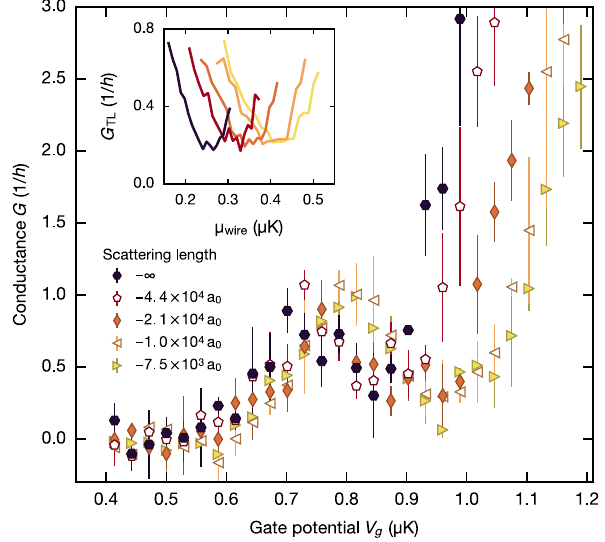
FIG. 5. Robustness of the gap with increasing interactions. Conductance G through a six-barrier lattice of height V 0 . 46 ð 2 Þ μ K as a function of gate potential V scattering lengths ranging from moderately attractive (yellow) to resonant interactions (dark purple). For a one-dimensional density of two particles per site, where the conductance minimum is observed, the Gaudin-Yang parameter at the wire center is equal to − 1 . 7 , − 1 . 9 , − 2 . 3 , − 2 . 6 , and − 3 . 0 for the five values of the scattering length ranging from − 7 . 5 × 10 3 a 0 to −∞ ; it increases upon decreasing density or equivalently gate potential (Appendix D). Inset: Conductance G Tomonaga-Luttinger theory around the conductance dip at temperature T ¼ 150